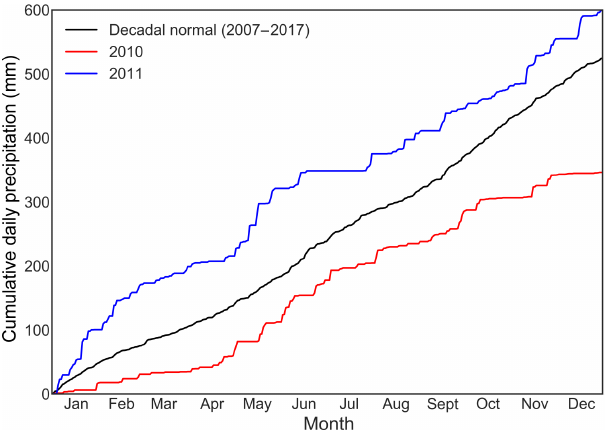
Figure 7. Cumulative daily precipitation recorded at the QRRC CAMnet station (using a heated Ogawa Seiki tipping bucket rain gauge) for 2010, 2011 and the overall mean for